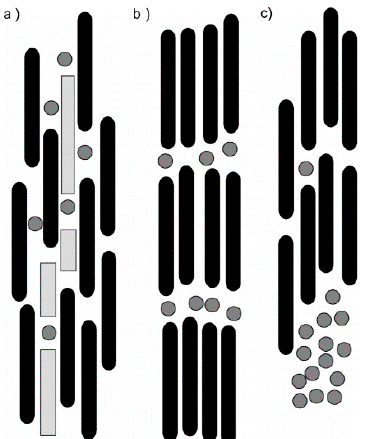
Figure 9. Illustrations of the ( a ) miscible (nematic) phase, ( b ) lamellar (layered) phase, and ( c ) immiscible phase. Reprinted with permission from Dogic, Z.; Frenkel, D.; Fraden, S. Enhanced